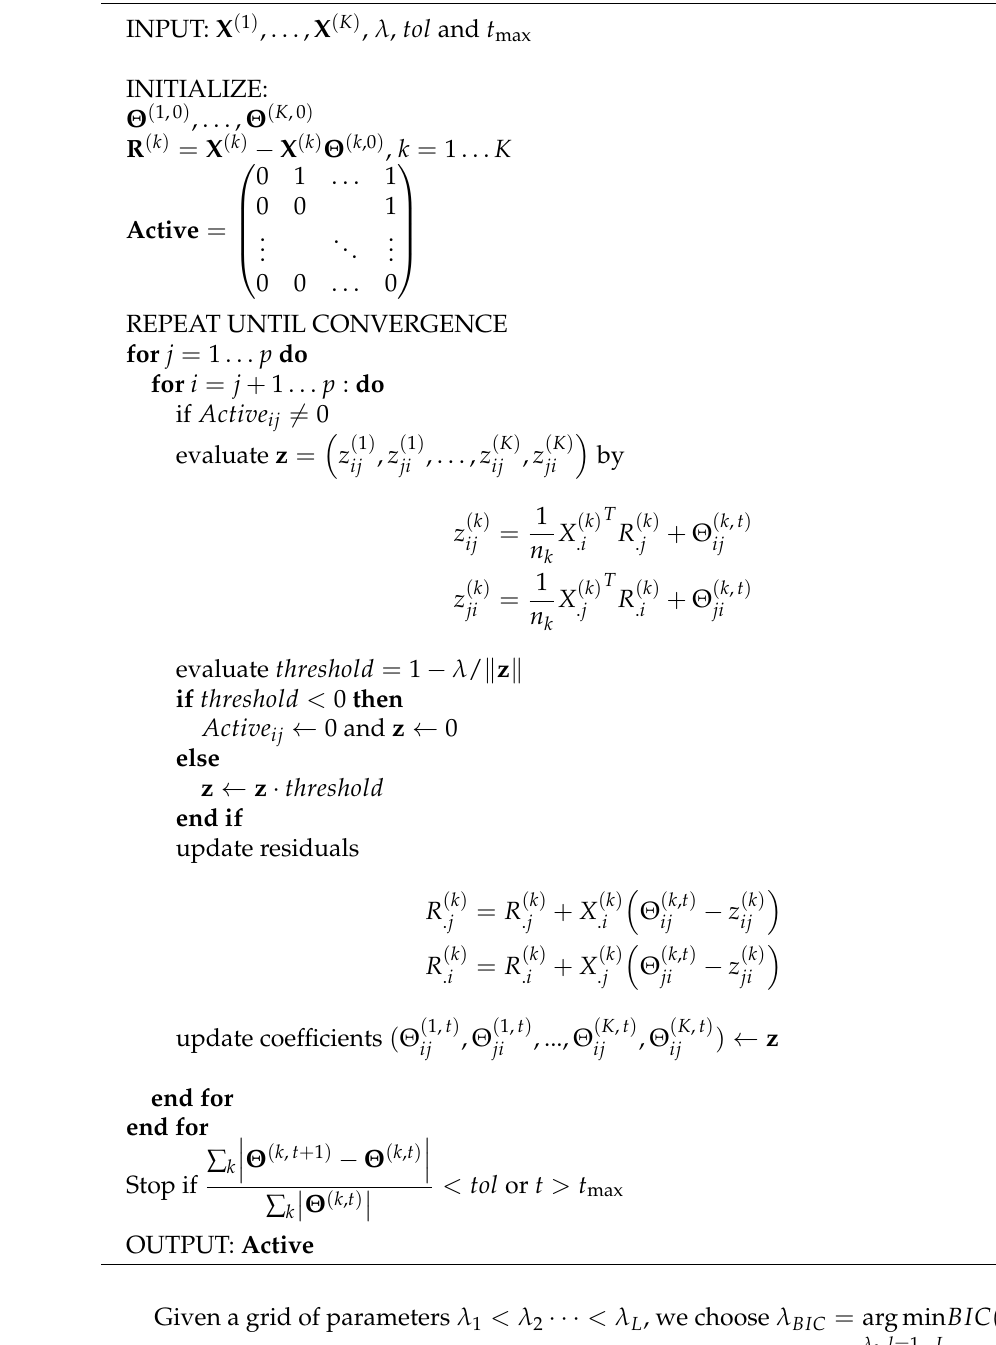
Algorithm 1 The jewel